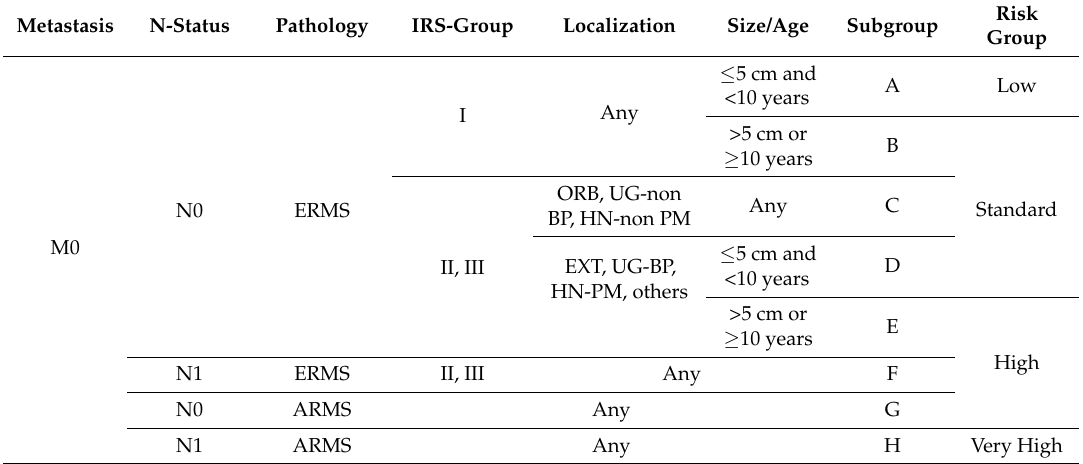
Table 4. Risk Stratification for Rhabdomyosarcoma according to European Studies. Stage IV is excluded.